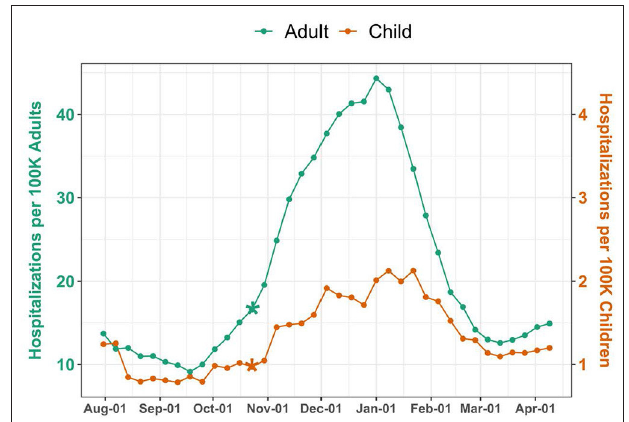
FIGURE 1 | National COVID-19 Hospitalizations among Children and Adults. Hospitalizations were standardized per 100,000 children or adults using US Census population estimates. The scale for pediatric hospitalizations is 10-fold less than for adults. Asterisks indicate significant ( P < 0.005) change